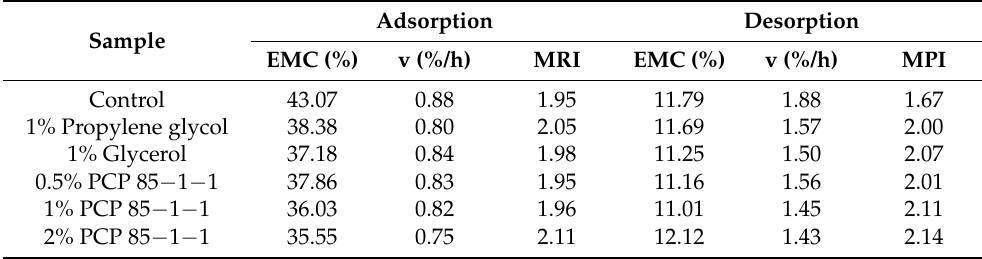
Table 3. EMC, v, MPI, and MRI of tobacco shred samples with different humectants in adsorption and desorption